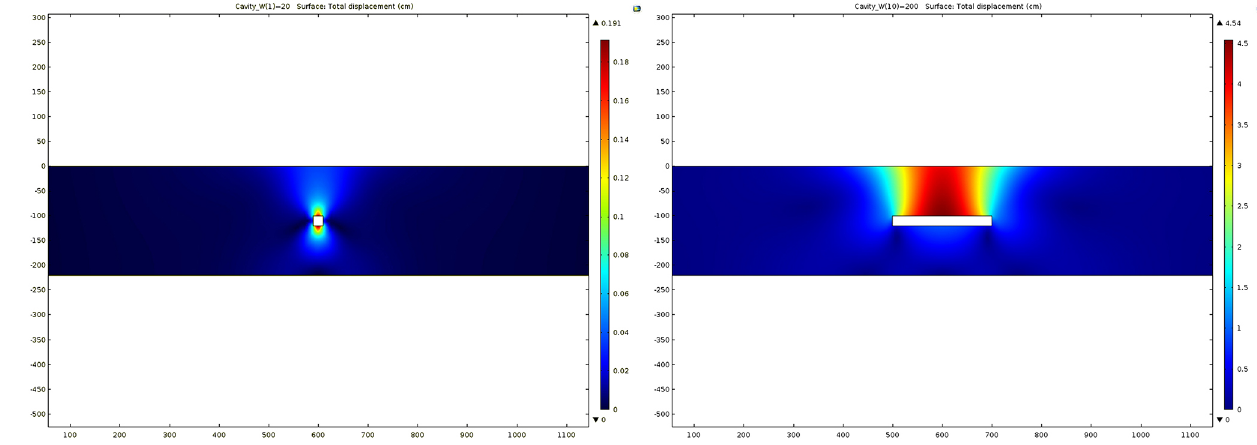
Figure 6. Total strata displacement around a shallow seated cavity.